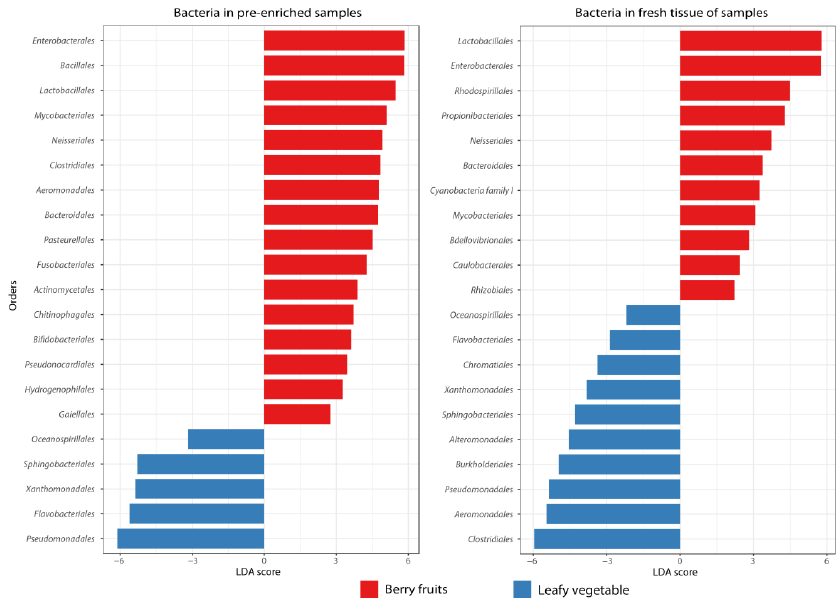
Figure 6. Barchart of biomarker among bacterial genera in samples of berry fruits and leafy vege- tables.